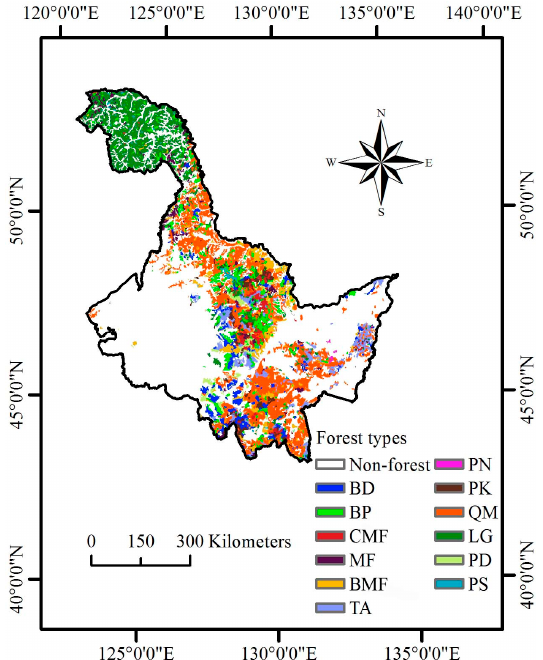
Figure 3. Spatial distribution of forest cover type in Heilongjiang Province, China. The map included three mixed forest type groups: coniferous mixed forest (CMF), broadleaved mixed forest (BMF), and coniferous and broadleaved mixed forest (MF), and nine pure forest types: Pinus koraiensis forest (PK), Larix gmelinii forest (LG), Pinus sylvestris forest (PS), Betula platyphylla forest (BP), Betula davurica forest (BD), Tilia amurensis forest (TA), Quercus mongolica forest (QM), Populus davidiana forest (PD), and Populus nigra forest (PN).